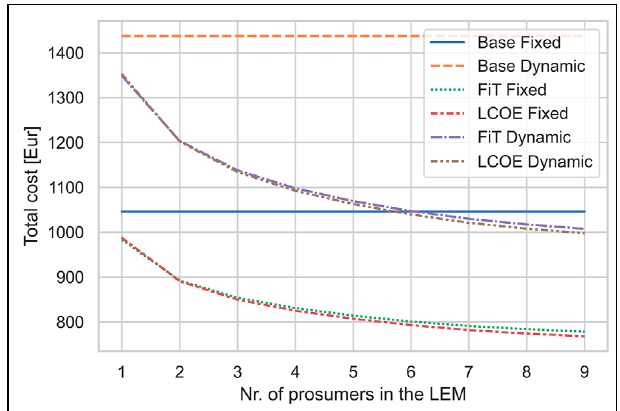
FIGURE 11 | Annual cost for Consumer 3, depending on number of prosumers in the neighborhood.